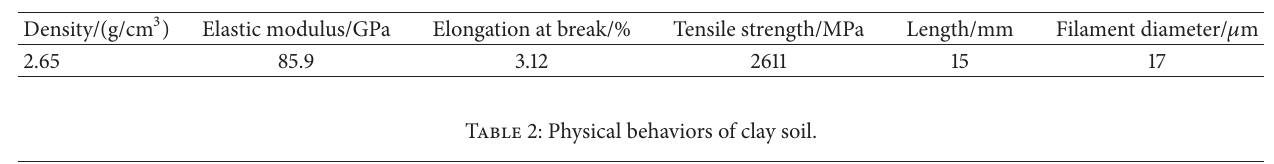
Table 1: Physical-mechanical behaviors of basalt fiber.